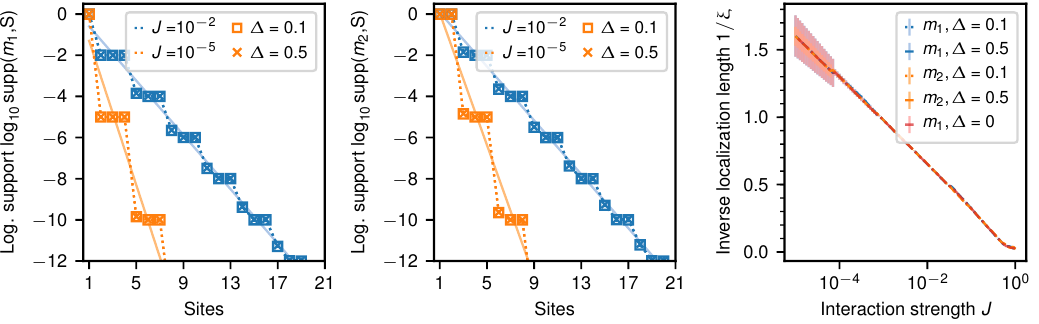
Figure 1: Left, Center: Logarithmic support log supp ( B , S ) of the edge modes m 1 10 and m for η = 0 on N = 32 sites, where S is a region starting from the left end of the 2 system where sites starting from the right end have been removed. Color encodes the interaction (or hopping) strength J and markers indicate the disorder strength ∆ . Each data point is an average over 100 realizations with error bars indicating the standard deviation of the data (smaller than symbols). Dotted lines are guides to the eye. Solid lines show linear fits of the data for ∆ = 0.1 , which allow to extract the localization length ξ . Right: Interaction dependence of the inverse localization length 1 /ξ for the edge modes. Here, color encodes the two modes and disorder strength ∆ . Data for all interaction strengths and modes overlaps strongly. The lines shown have been extrapolated by using 100 values of interaction strengths in the shown interval. We also include data without disorder. Here, the errorbars show the quality of the fit in form of the least-squares